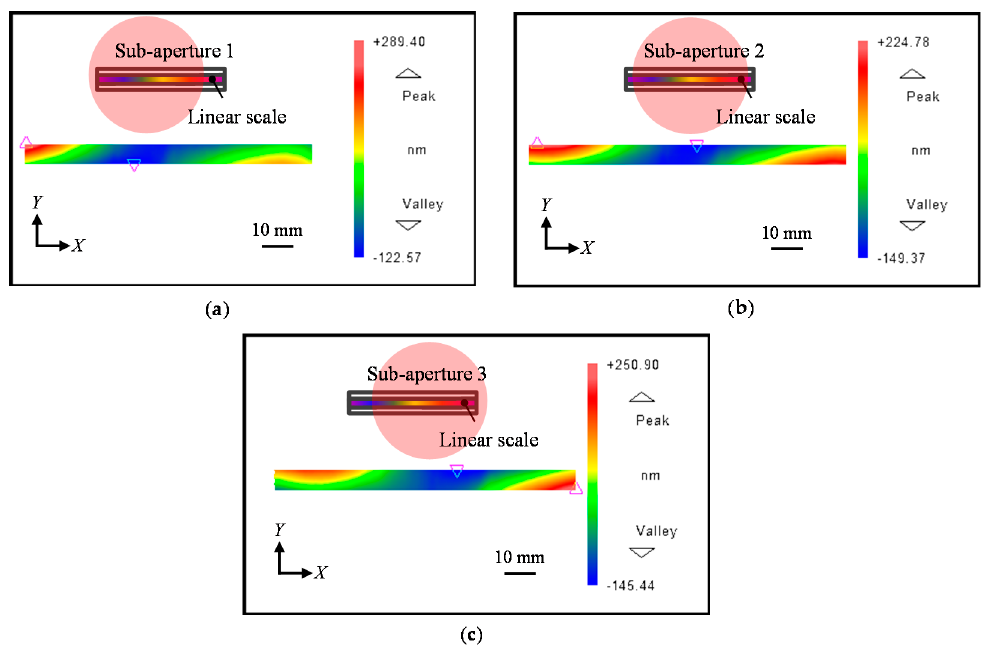
Figure 10. Measured positive first-order diffracted wavefront from the linear scale grating. ( a ) X -directional positive first-order diffracted beam from Sub-aperture 1; ( b ) X -directional positive first-order diffracted beam from Sub-aperture 2; ( c ) X -directional positive first-order diffracted beam from Sub-aperture 3.